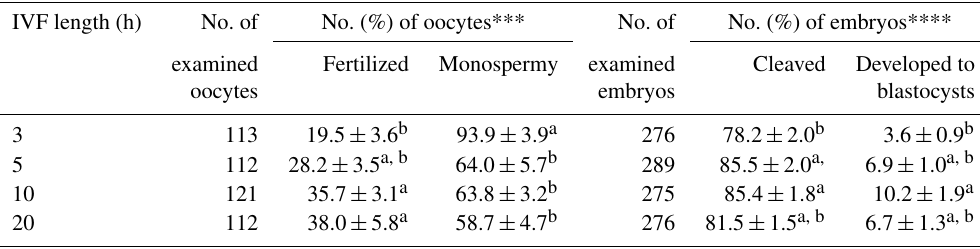
Table 3. Effects of sperm–oocyte co-incubation length on the fertilization and development of porcine oocytes fertilized with frozen–thawed spermatozoa from microminipig